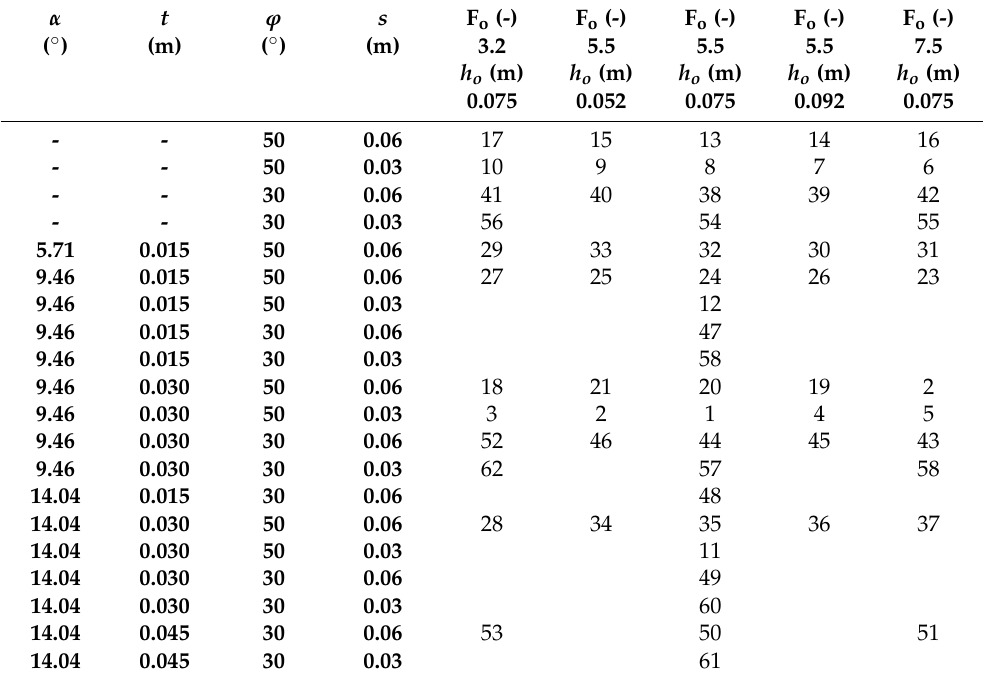
Table 1. Test numbers and their parameters: deflector angle α , deflector height t , chute angle ϕ , step height s , Froude number F o and flow depth h o